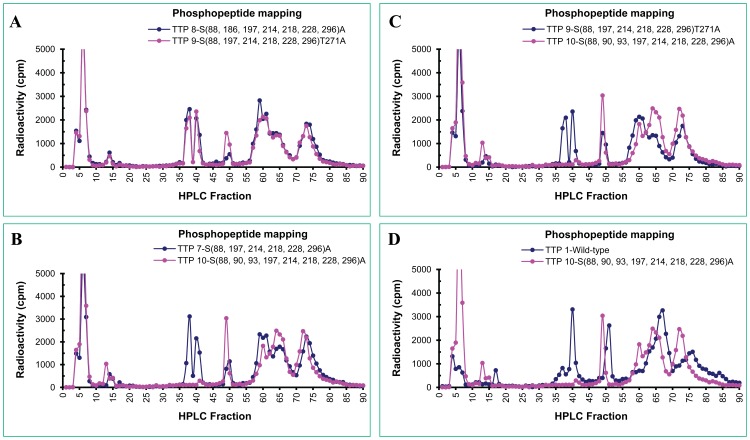
Phosphopeptide mapping of the wild-type and mutant hTTP proteins from transfected human cells.The methods for generating the phosphopeptide mapping profiles were identical to those described in Figure 6 legend. The phosphopeptide profiles in each pair of hTTP proteins are (A) S(88,186,197,214,218,228,296)A vs. S(88,197,214,218,228,296)T271A, (B) S(88,197,214,218,228,296)A vs. S(88,90,93,197,214,218,228,296)A, (C) S(88,197,214,218,228,296)T271A vs. S(88,90,93,197,214,218,228,296)A, and (D) Wild-type vs. S(88,90,93,197,214,218,228,296)A.